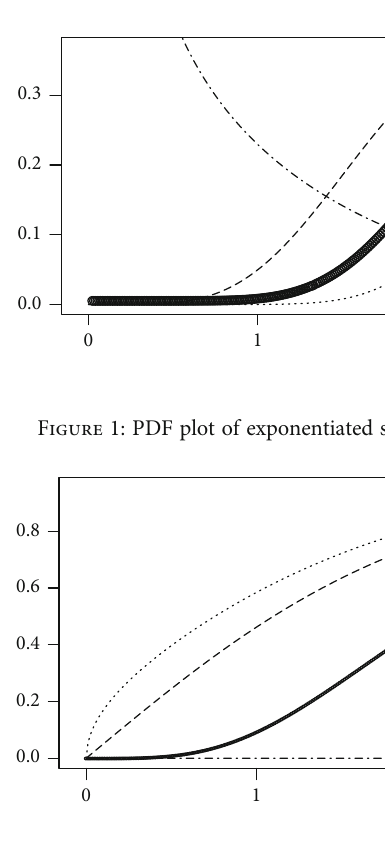
Figure 2: Hazard plot of exponentiated standardized half logistic distribution.